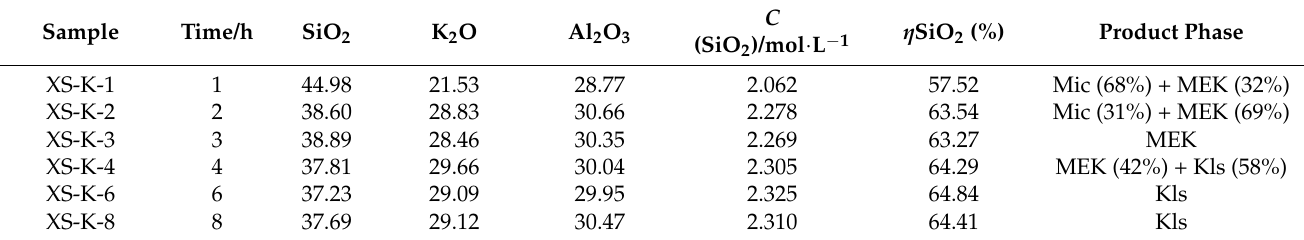
Figure 2. SEM images of K-feldspar ( a ) and the dissolution and precipitation products of K-feldspar in KOH solution for 0.5 ( b , c ), 1 ( d ), 2 ( e ), 3 ( f ), 4 ( g ), 6 ( h ) and 8 h (i). Table 2. The chemical composition of precipitation samples obtained after hydrothermal treatment of K-feldspar (Mic— microcline,